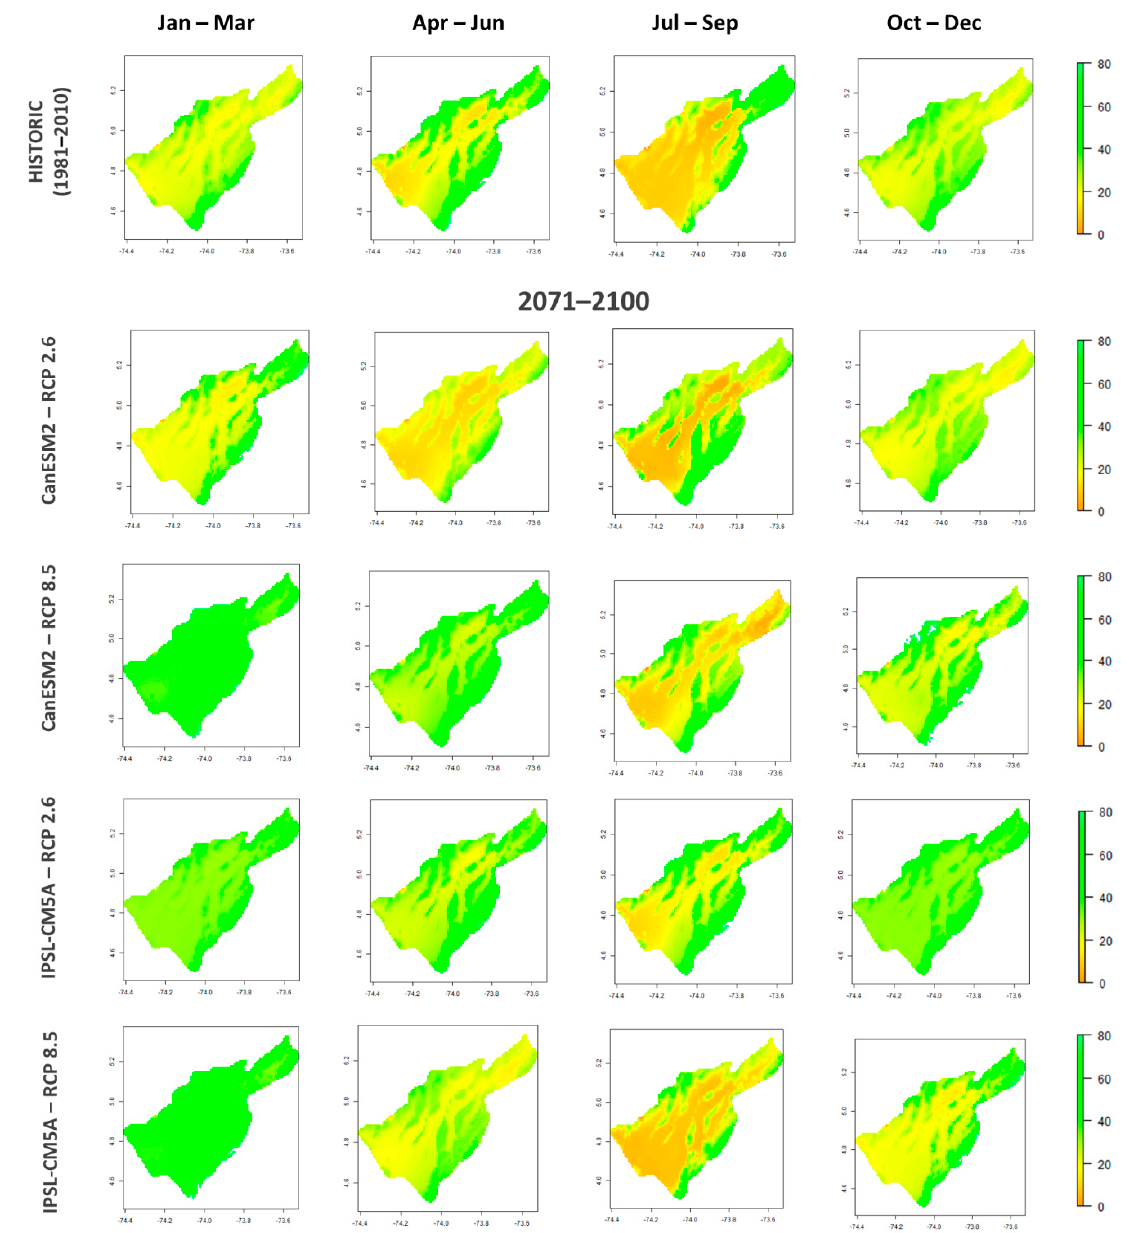
Figure B6. Stream Flow 2071–2100 Figure A10. Stream Flow